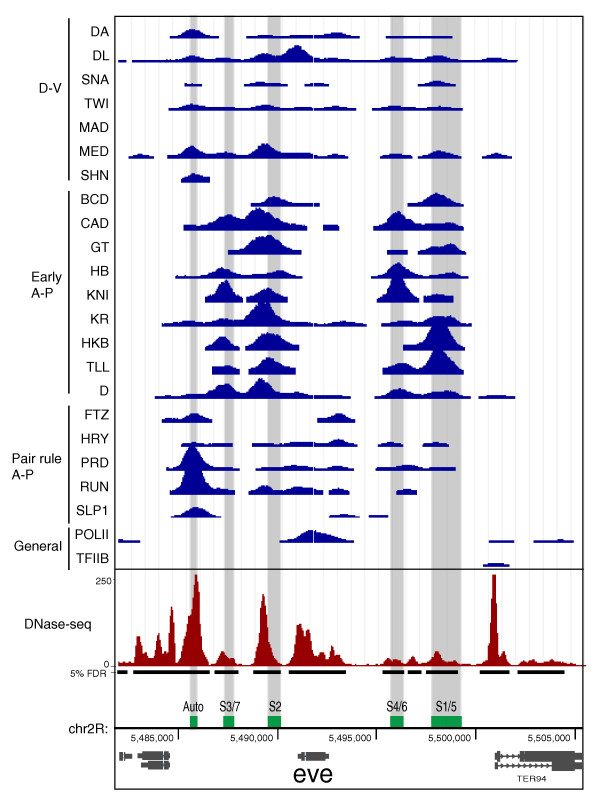
DNaseI accessibility and in vivo DNA binding by transcription factors across the eve locus. DNA binding in stage 5 embryos is shown as ChIP-chip scores (blue) for 675-bp windows that fall above a 1% FDR threshold for 21 sequence-specific transcription factors, TFIIB and the transcriptionally active form of RNA polymerase II (POLII). The sequence-specific factors are grouped into three major regulatory classes that regulate patterning along the Dorsal-Ventral axis of the embryo (D-V), initiate patterning along the Anterior-Posterior axis (Early A-P), or establish later pair rule patterns along the Anterior-Posterior axis (Pair rule A-P). DNaseI accessibility at stage 5 is shown for 75-bp windows of sequence tag density (red) along with the locations of accessible regions above the 5% FDR threshold (black bars). At the bottom, the locations of major RNA transcripts are shown (grey) as well as the autoregulatory CRM (Auto) and the four stripe initiation CRMs (S3/7, S2, S4/6 and S1/5) (green). Nucleotide coordinates in the genome are given in base pairs.